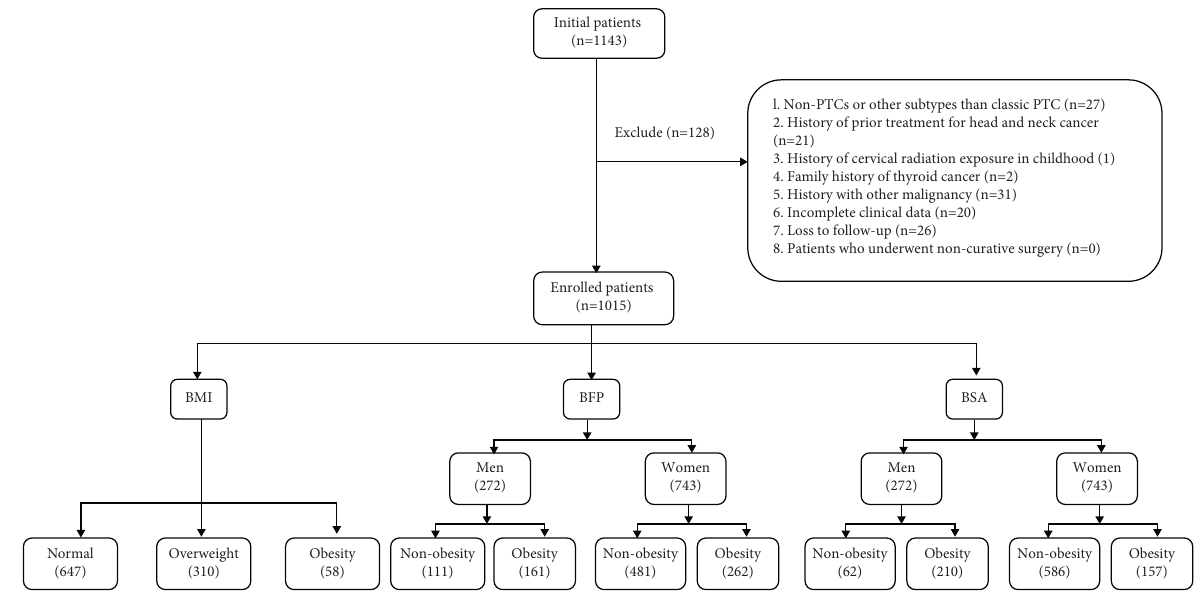
Figure 1: Flowchart of the patients enrolled in this